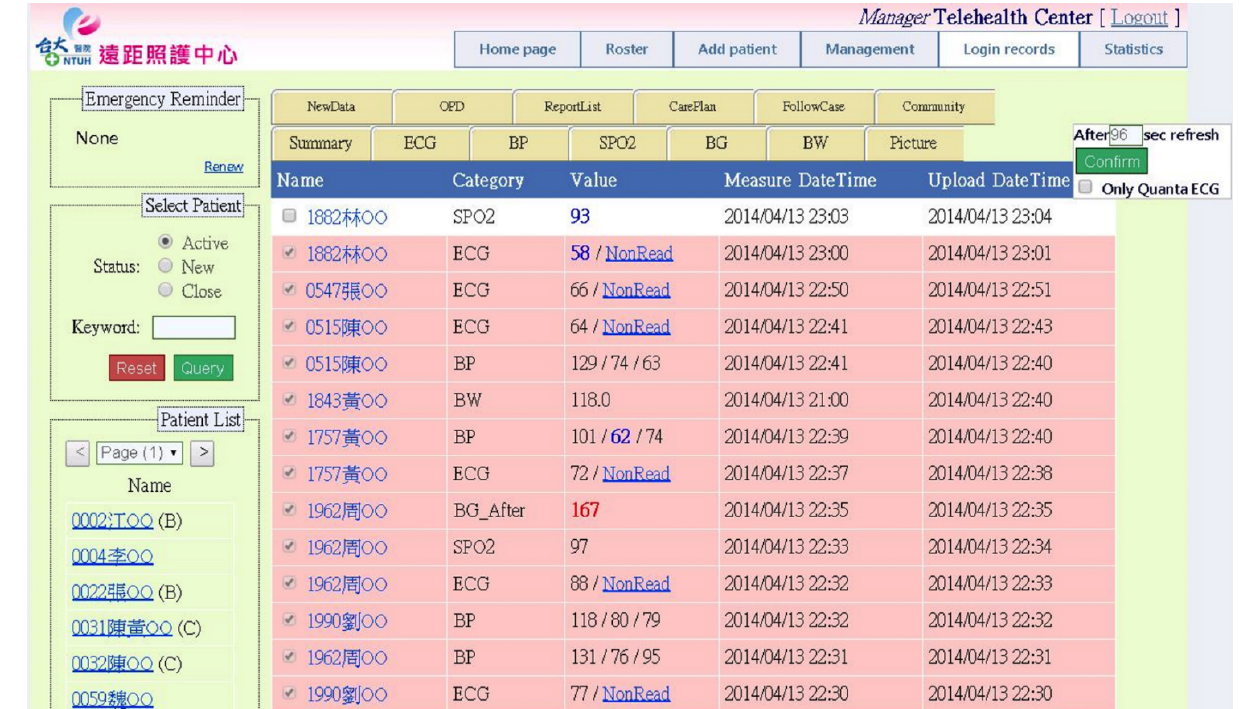
Figure 1. Screenshot of telehealth platform. All biometric and clinical data of patients receiving telehealth care can be assessed from this Internet-based database. Abnormal value marked in